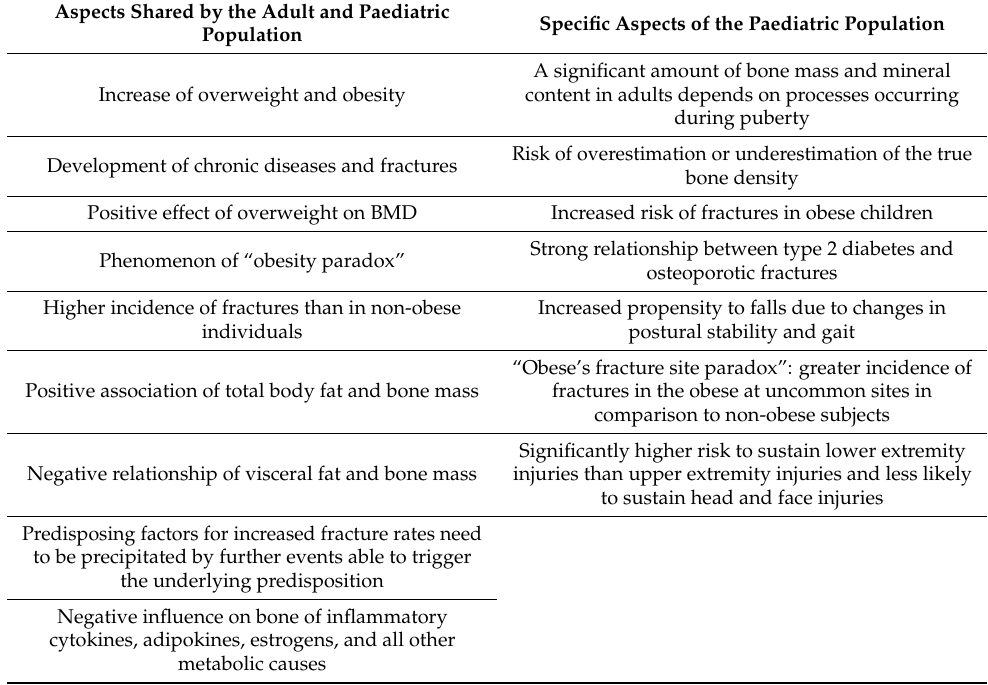
Table 2. Aspects and consequences of obesity in relation to bone health that are shared among the adult and paediatric populations (left column) and those peculiar of the paediatric popula- tion (right